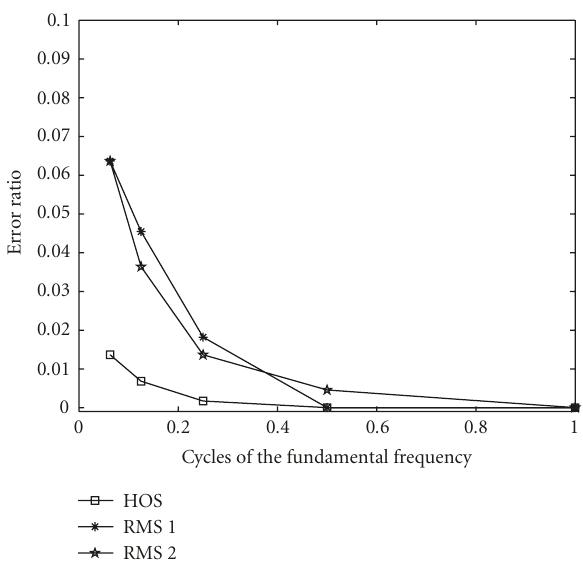
Figure 9: Error detection rate when the frame lengths are 1/16, 1/8, 1/4, 1/2, and 1 cycles of the fundamental component.